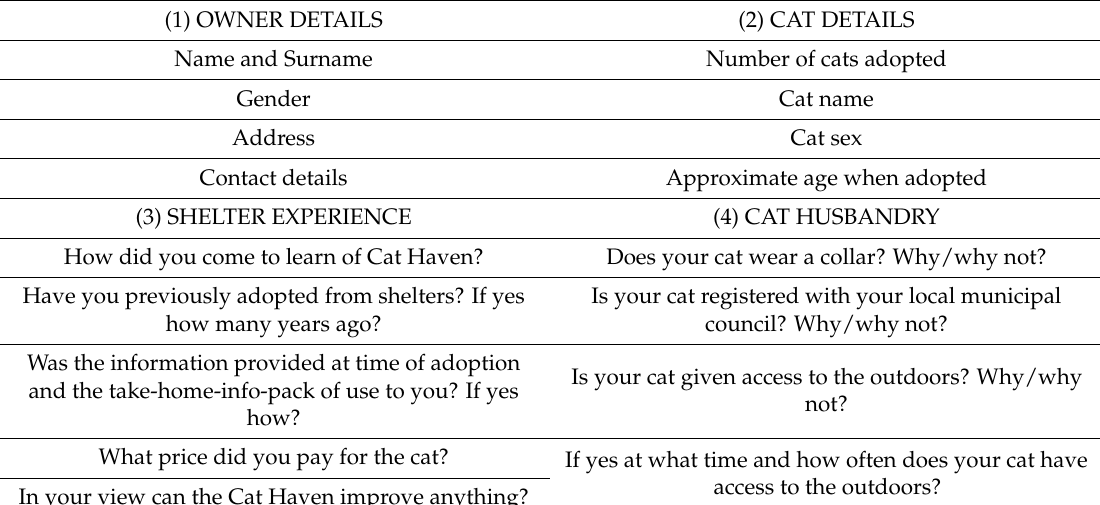
Table A1. Post-adoption surveys using email, letter and telephone questionnaires were identical for people who adopted cats for free, or for a